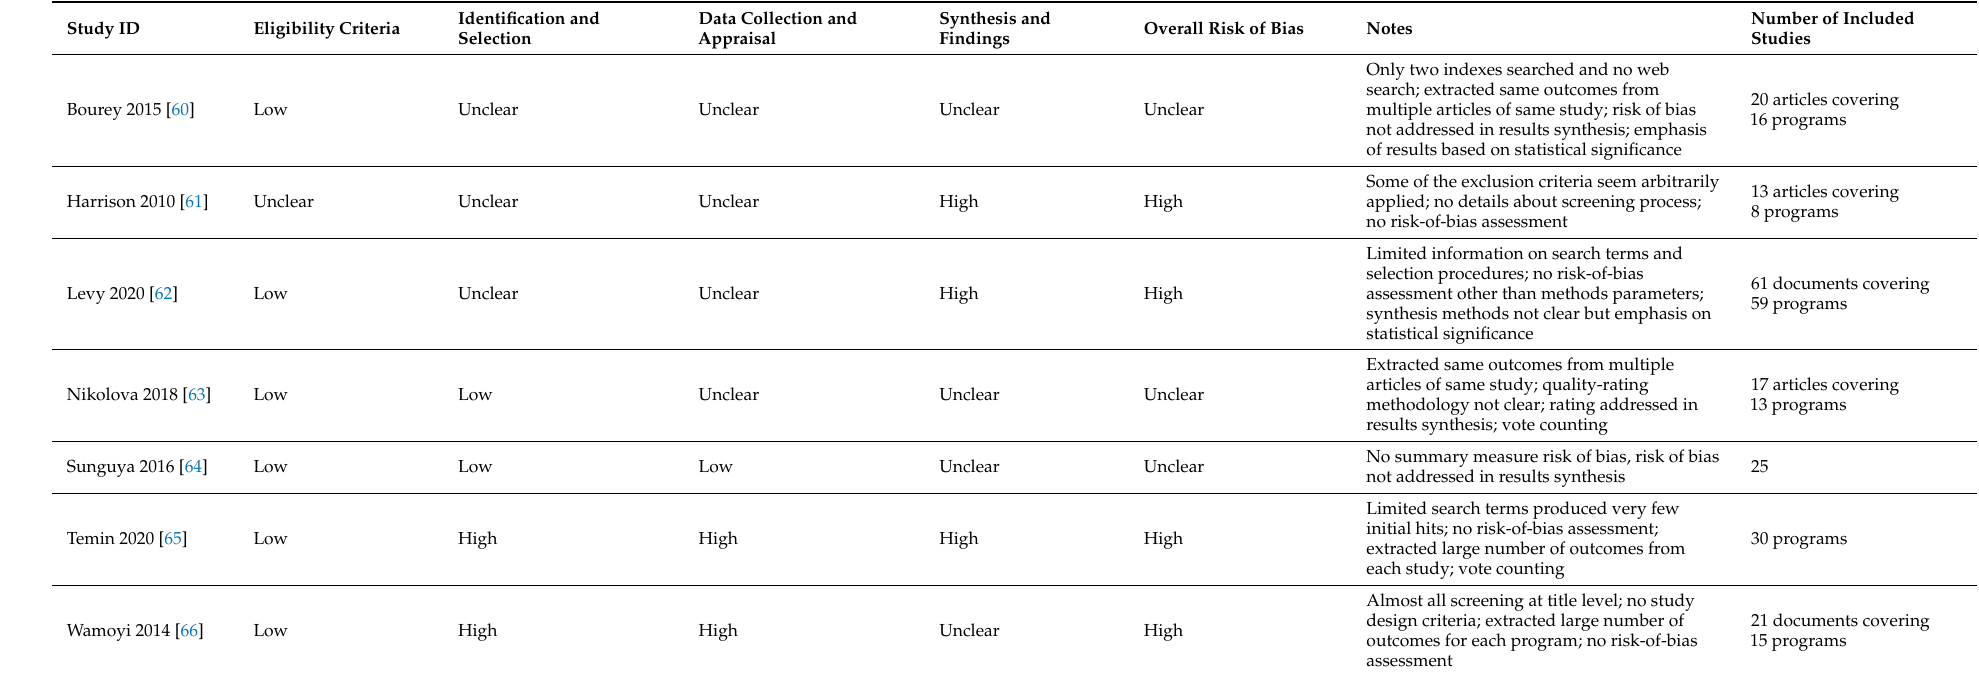
Table A2. Risk-of-bias assessment and number of included studies for systematic